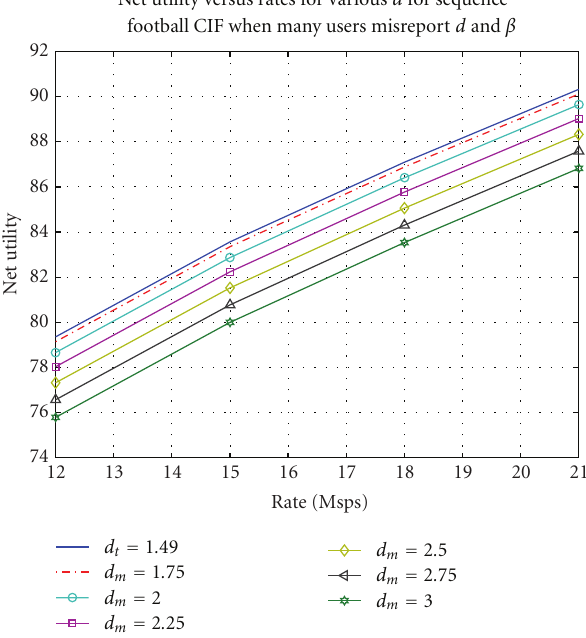
parameter d for sequence football CIF and other misreports: d d t = true value; m = misreprted